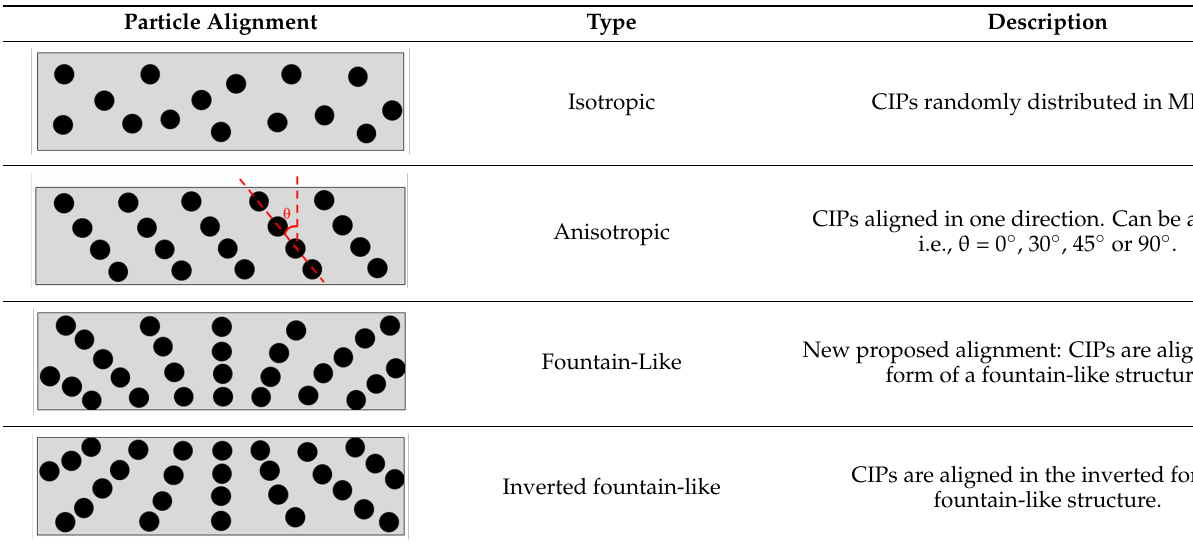
Table 1. Illustration of the types of CIP alignment in MRE